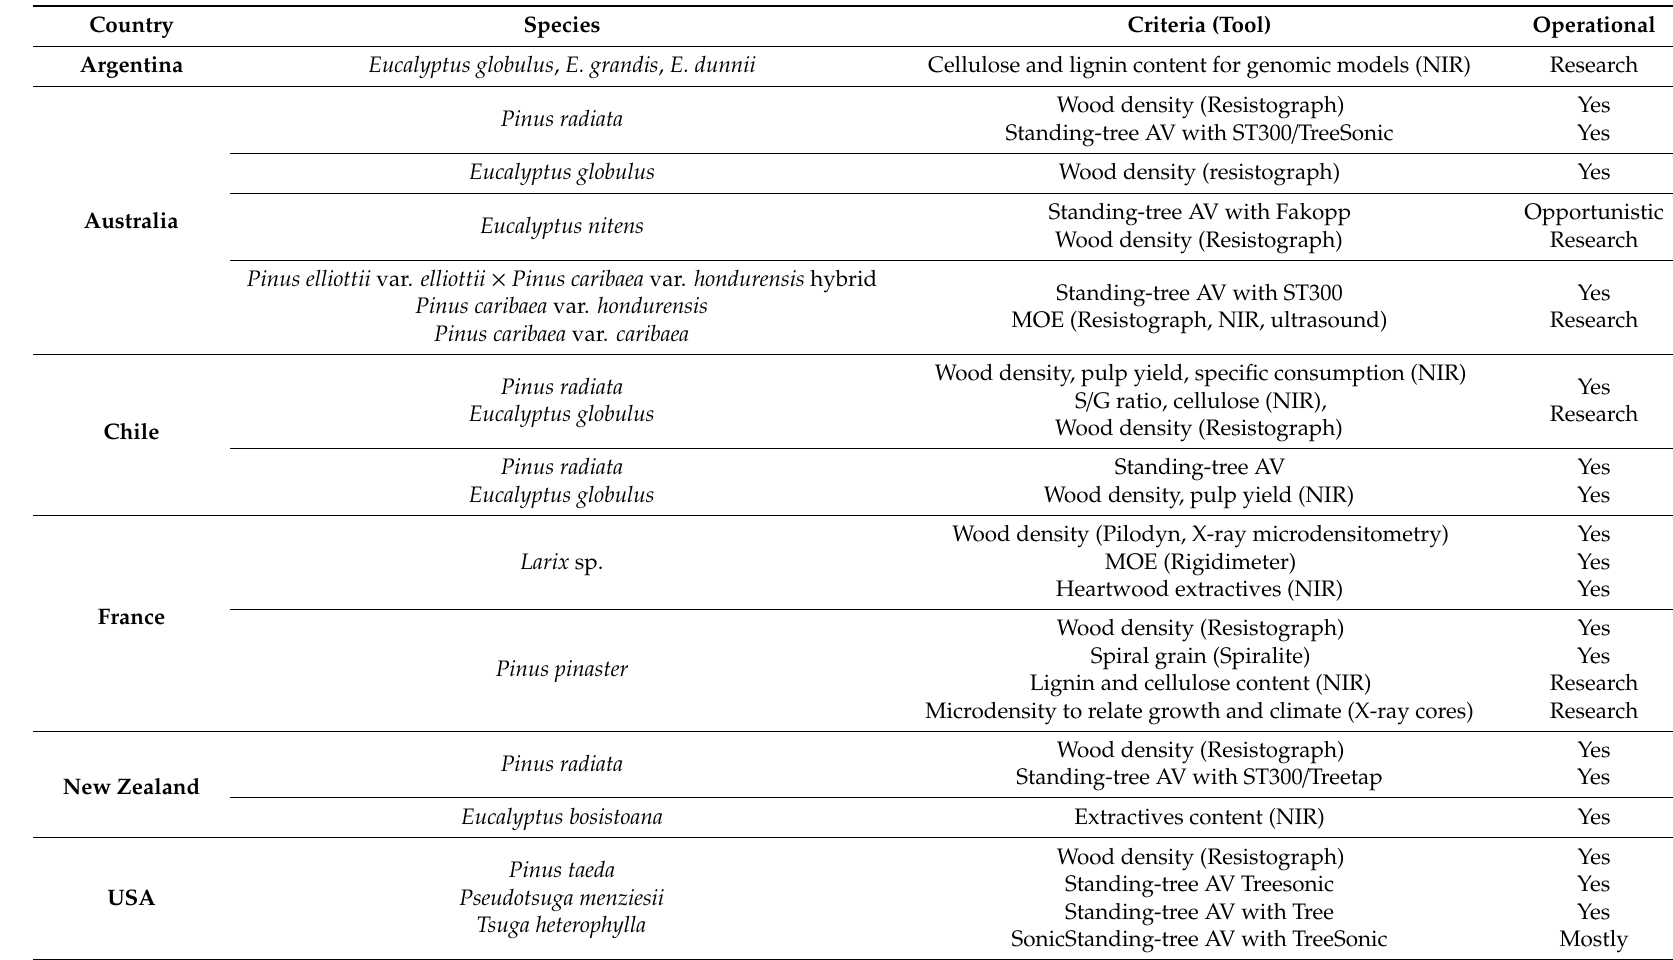
Table 1. Wood properties criteria used for early selection in a number of countries. Only criteria and tools used frequently are